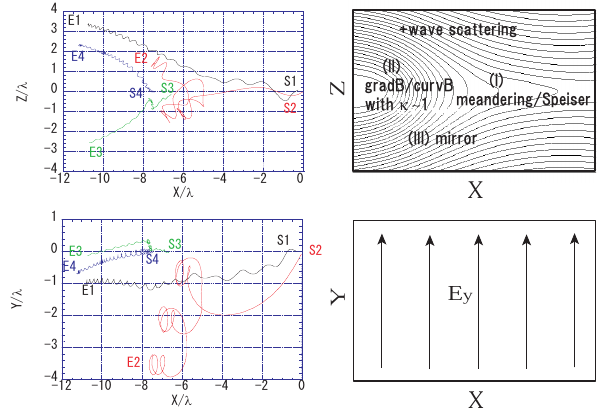
Fig. 43. Several electron trajectories in the reconnection region. (From Hoshino et al.,